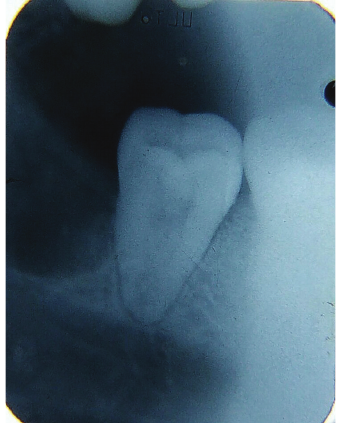
Figure 2: Postoperative retroalveolar radiography of postextraction tooth socket (wisdom